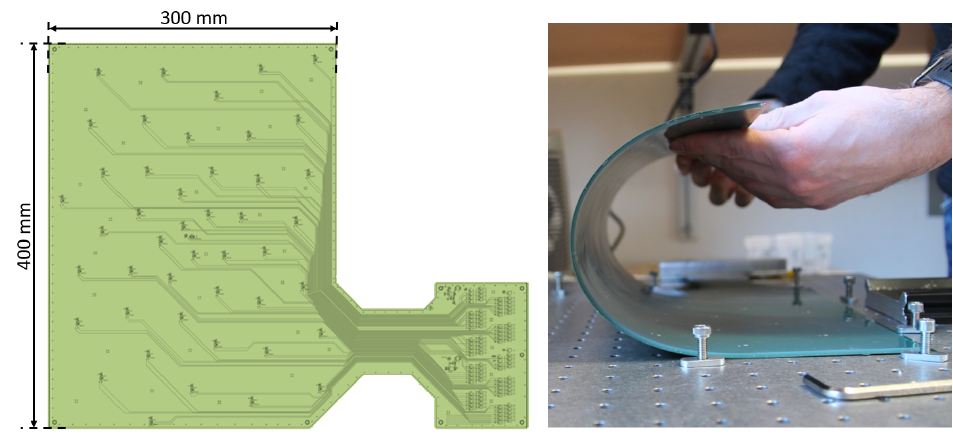
Figure 4. Left: Schematic of the printed circuit board with dimensions. Right: Bending demonstration of the